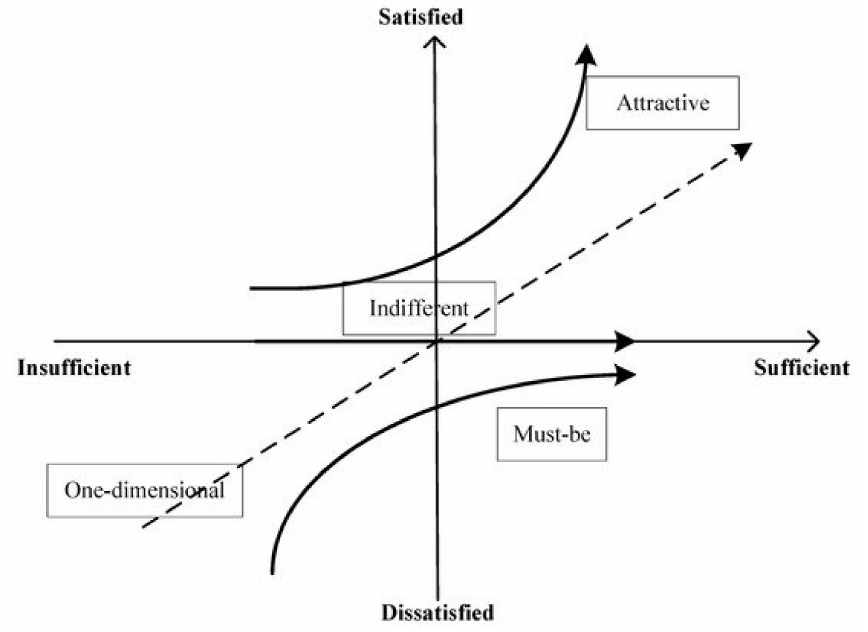
Figure 1. The Kano model [23], as suggested by Jin et al.